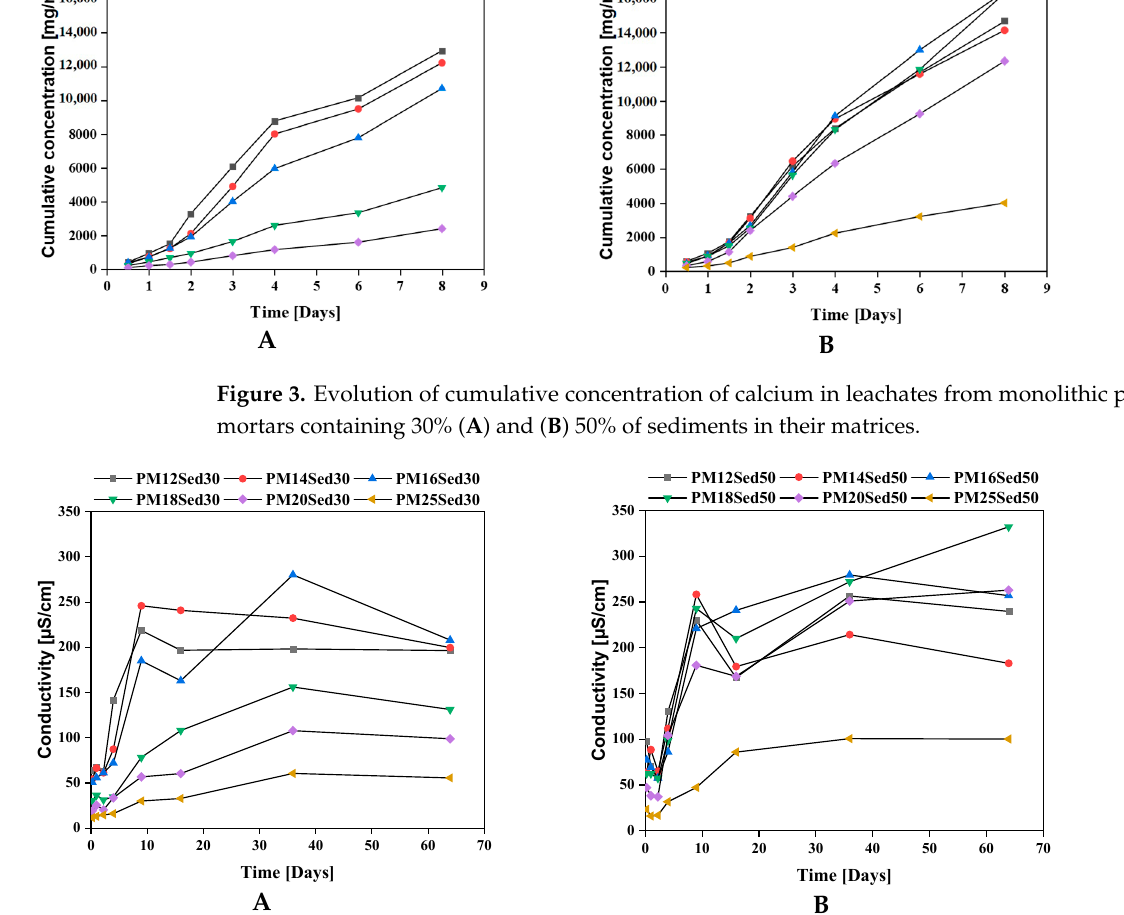
Figure 4. Evolution of conductivity in eluates of polymer mortar including 30% ( A ) and 50% ( B ) of sediments.